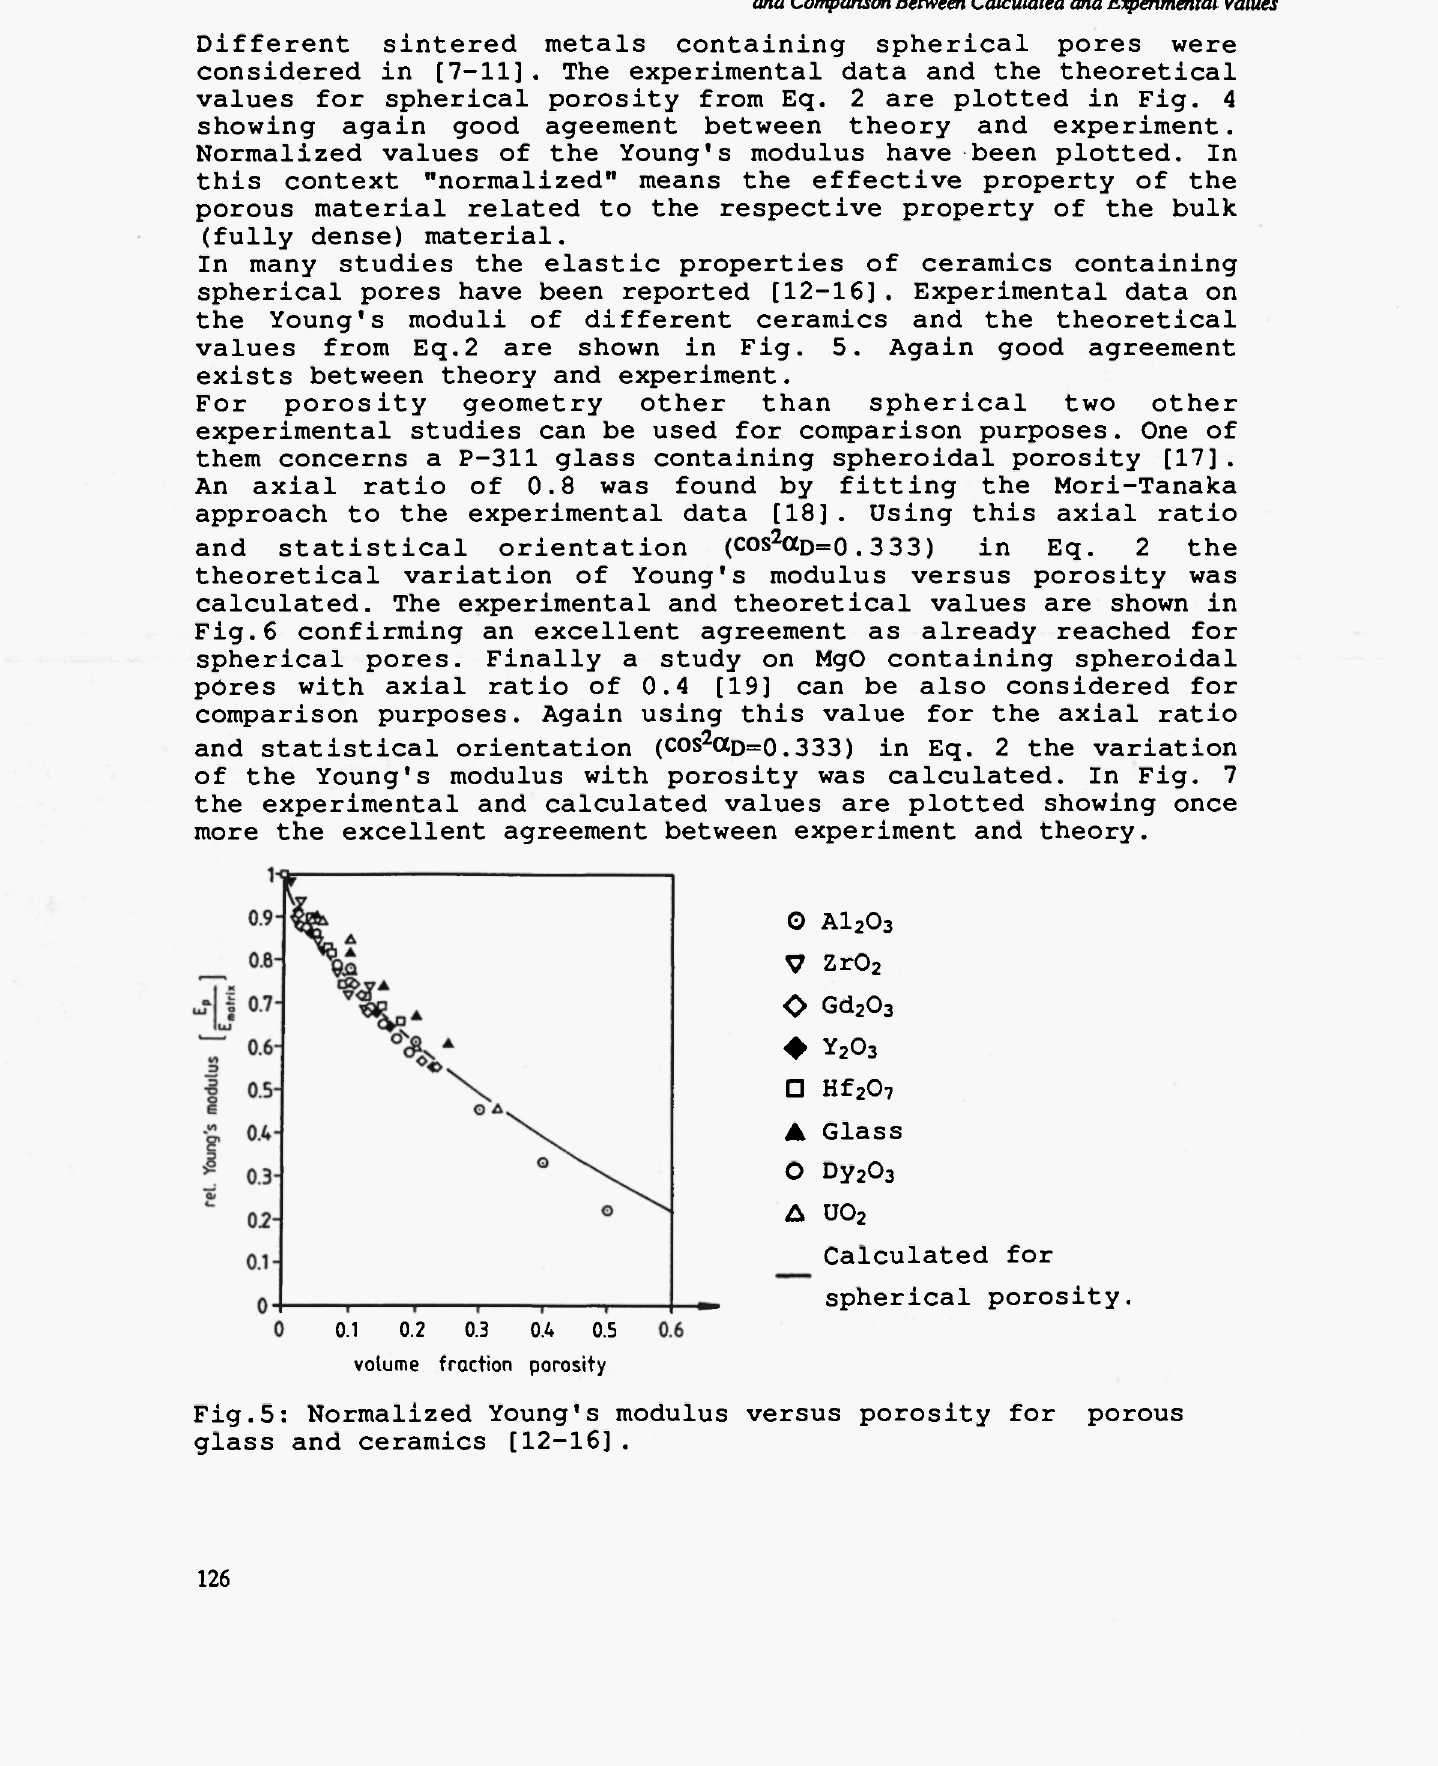
Fig.5: Normalized Young's modulus versus porosity for porous glass and ceramics